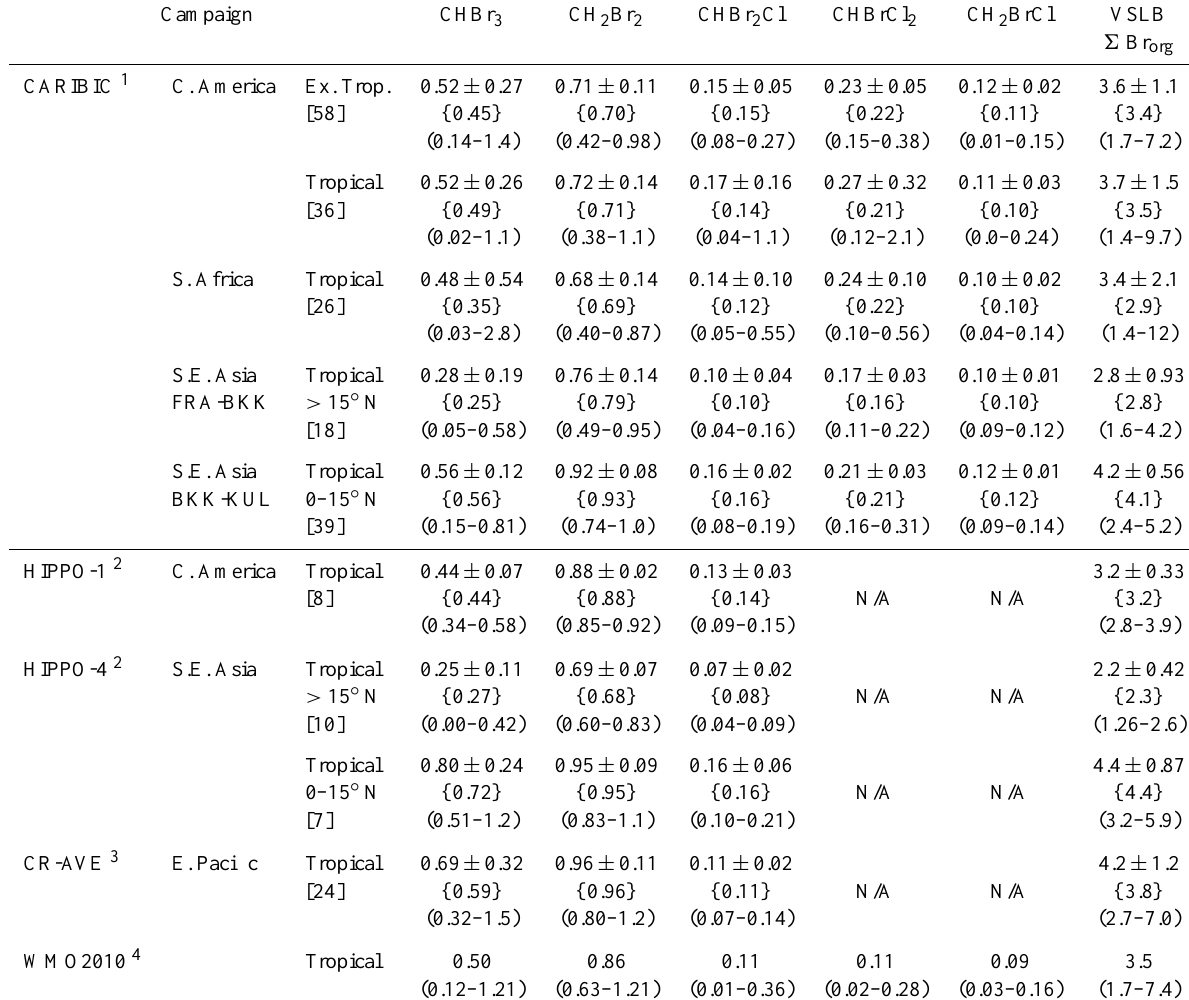
Table 2. Summary of tropospheric tropical and extra-tropical 10–12.3km mid-upper tropospheric means and medians for the bromomethanes and total VSLB-derived organic bromine (VSLB 6 Br org ) in Central American, South African and Southeast Asian CARIBIC flights (FRA- CCS/BOG, FRA-CPT, FRA-BKK and BKK-KUL) with comparison to literature values. Tropical is defined as between 24.4378 ◦ S and 24.4378 ◦ N. Values are means with ± 1 σ , medians in curly brackets and minimum/maximum values in parentheses except for WMO 2010 where medians are not given. Values in square brackets are the number of samples included in the average. All values are given in parts per trillion